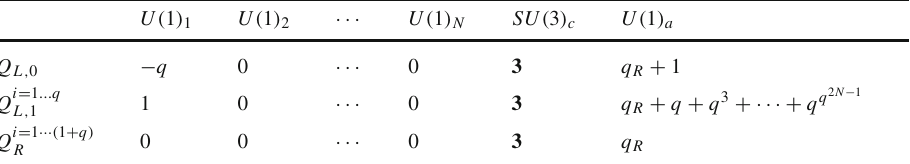
mass terms from higher dimensional operators ( q R is